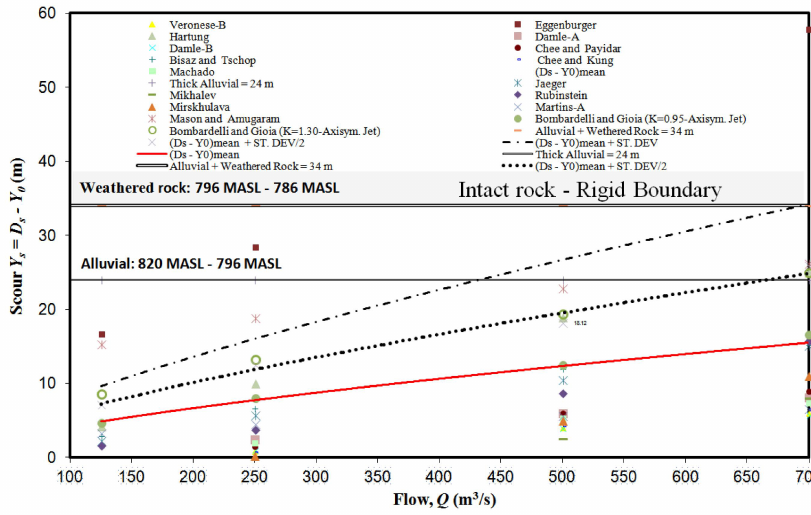
Figure 2. Scour of alluvial and weathered rock for the free surface